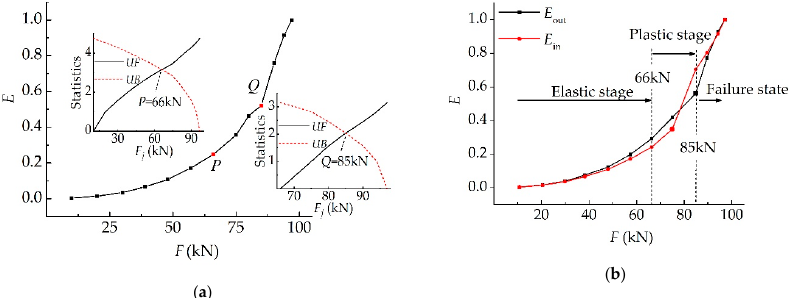
Figure 3. The generalized strain energy density-based curves of the arch model: ( a ) the E - F curve and characteristic loads; ( b ) the E in - F and E out - F curves.